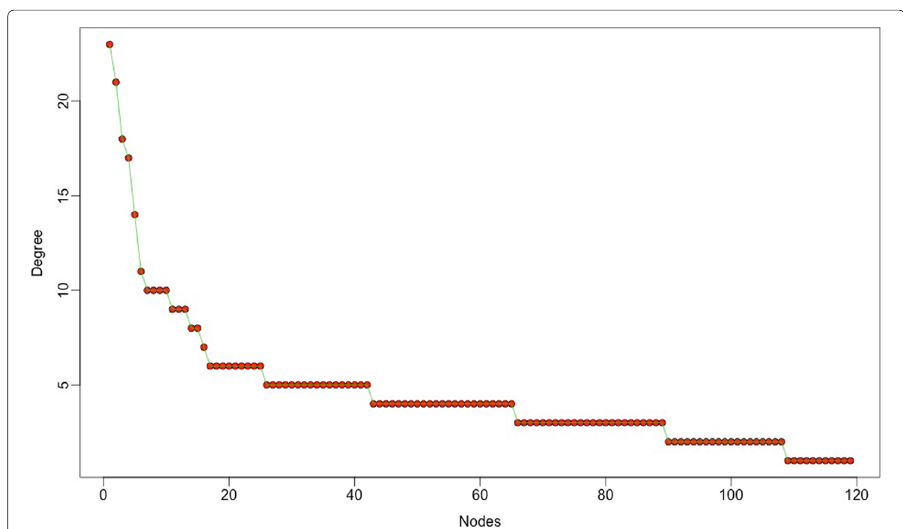
Fig. 3 Node degrees of the Noordin Top terrorist network. Noordin Top has degree 23, Organization 5 (Affiliation 5–Jemaah Islameyah) has 21, Operation 1 (Affiliation 9–Australian Embassy bombing Sep 2004) has 18 and Azhari Husin has 17. The two top actors under different centrality measures of the network (see (Roberts and Everton 2011; Alzahrani and Horadam 2014)), Noordin Top and Azhari Husin, stand